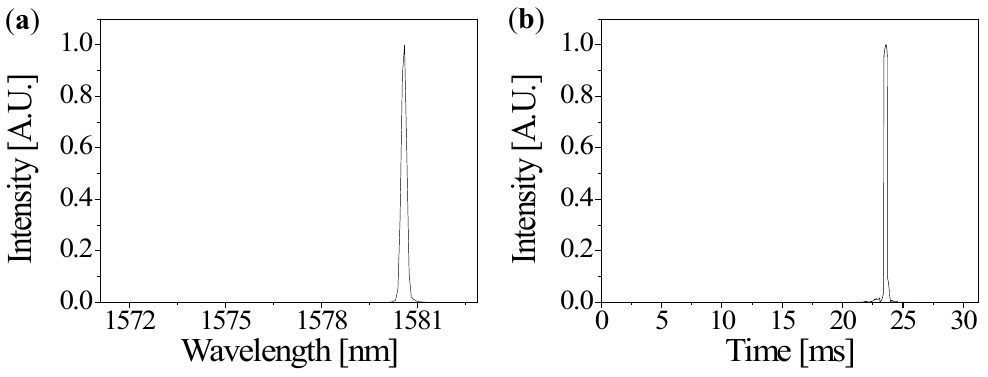
Figure 5. The measured reflection signal of the FBG detected by ( a ) the OSA and ( b ) the LabVIEW.